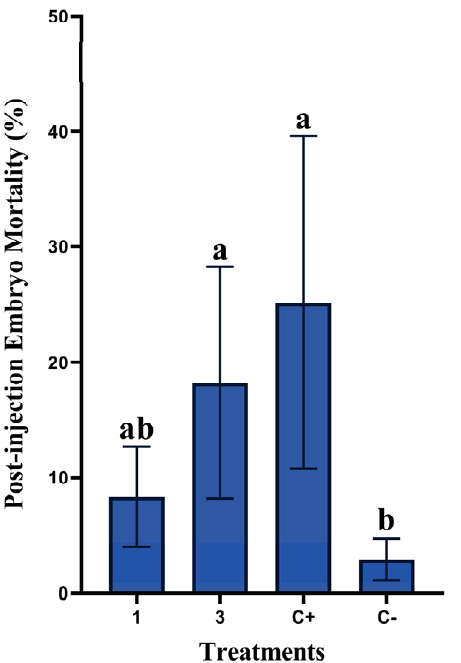
Figure 3. Effects of in ovo administration of different concentrations of rosemary essential oil on post-injection embryo mortality rates in non-injected group (C − ), positive control (eggs injected with distilled water) (C+), and in treatments with rosemary EO at 1 or 3 µL/egg (five replicates/group). Different letters (a, b) indicate a statistically significant difference ( p < 0.05). Values are represented as mean ± standard error of the mean (SE).